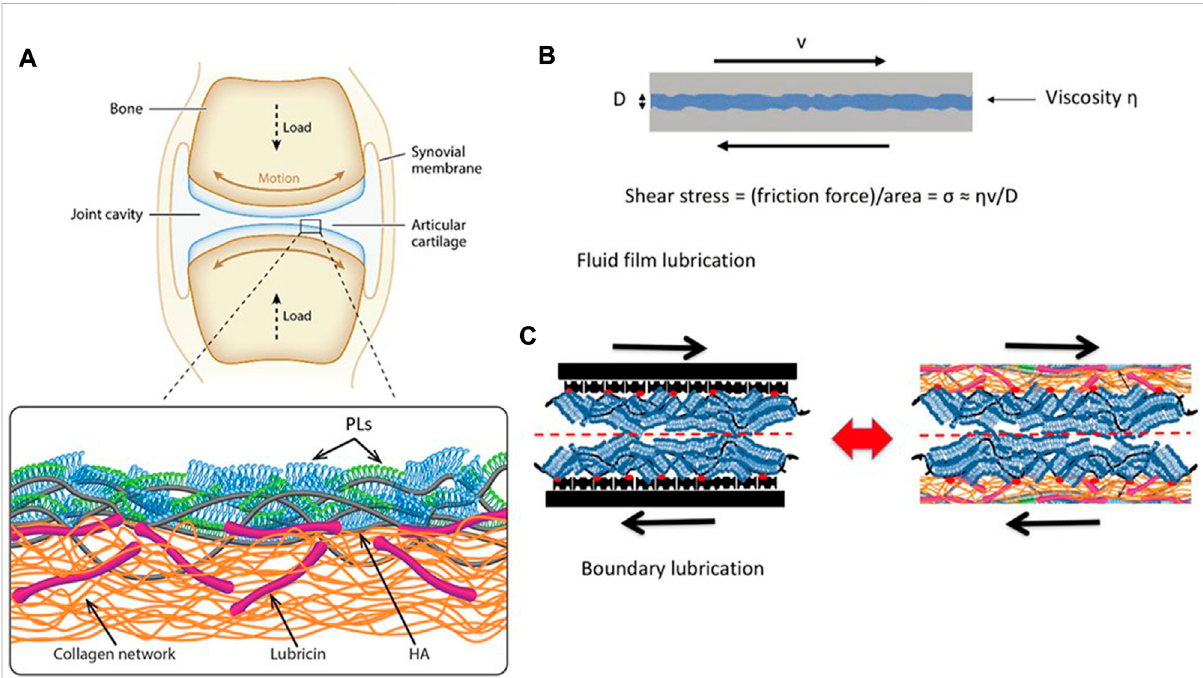
FIGURE 2 (A) IllustrationofasynovialjointanditsboundarylayerconsistingoflinearHA(gray),mucinousglycoproteinlubricin(purple),andphospholipids (monolayer, green; bilayer, blue) on a collagen network (orange). (B) Illustration of a fl uid- fi lm lubrication model. When the joint moves, a fl uid layer betweencartilagesurfacesseparatesthecartilagesurfaces,reducingfrictionandprotectingthearticularcartilage.Theshearstress σ s maybewritten intheNewtonianform, σ s = (shear rate)× (effective fl uidviscosity). (C) Inthisboundary lubricationmodel,friction occurs between theinterface of the articular cartilage surface, not in the substrates beneath it. The frictional dissipation in the boundary lubrication model is closely linked to the molecules in boundary layers (Lin and Klein, 2022). Copyright 2022, Acc Mater